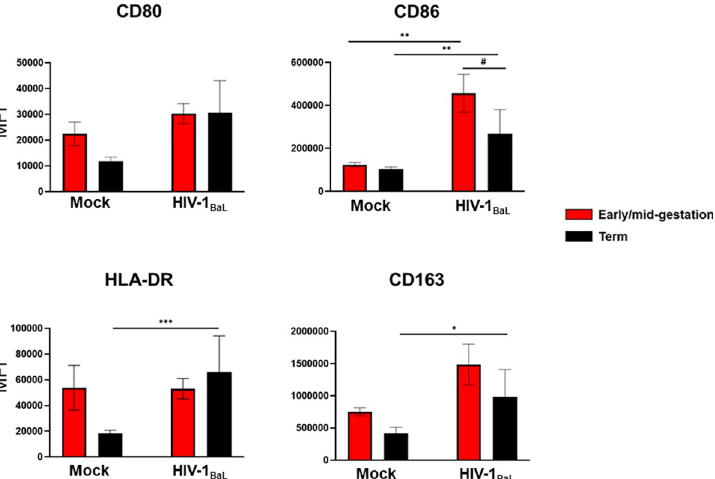
Fig 3. HIV Infection Induces Activation of HCs. Hofbauer cells from early gestation (red bars) and term (black bars) placentae were infected with HIV-1 BaL or mock infected. Surface-marker expression of CD80, CD86, HLA-DR, and CD163 was determined by flow cytometry 48 hours post-infection (hpi). Data shown are expressed as the mean ± standard error of biological triplicates from 10 individual donors analyzed by paired t-test analysis (mock infected HCs vs HIV infected HCs) and unpaired t-test analysis (early/mid-gestation HCs vs. term HCs)using the two- stage linear step-up procedure of Benjamini, Krieger and Yekutieli. ��� p < 0.0001, �� p < .001, and � p < .05 indicate significance between HIV-infected HCs and mock-infected HCs. #p < .05 indicate significance between early/mid- gestation HCs and term HCs.